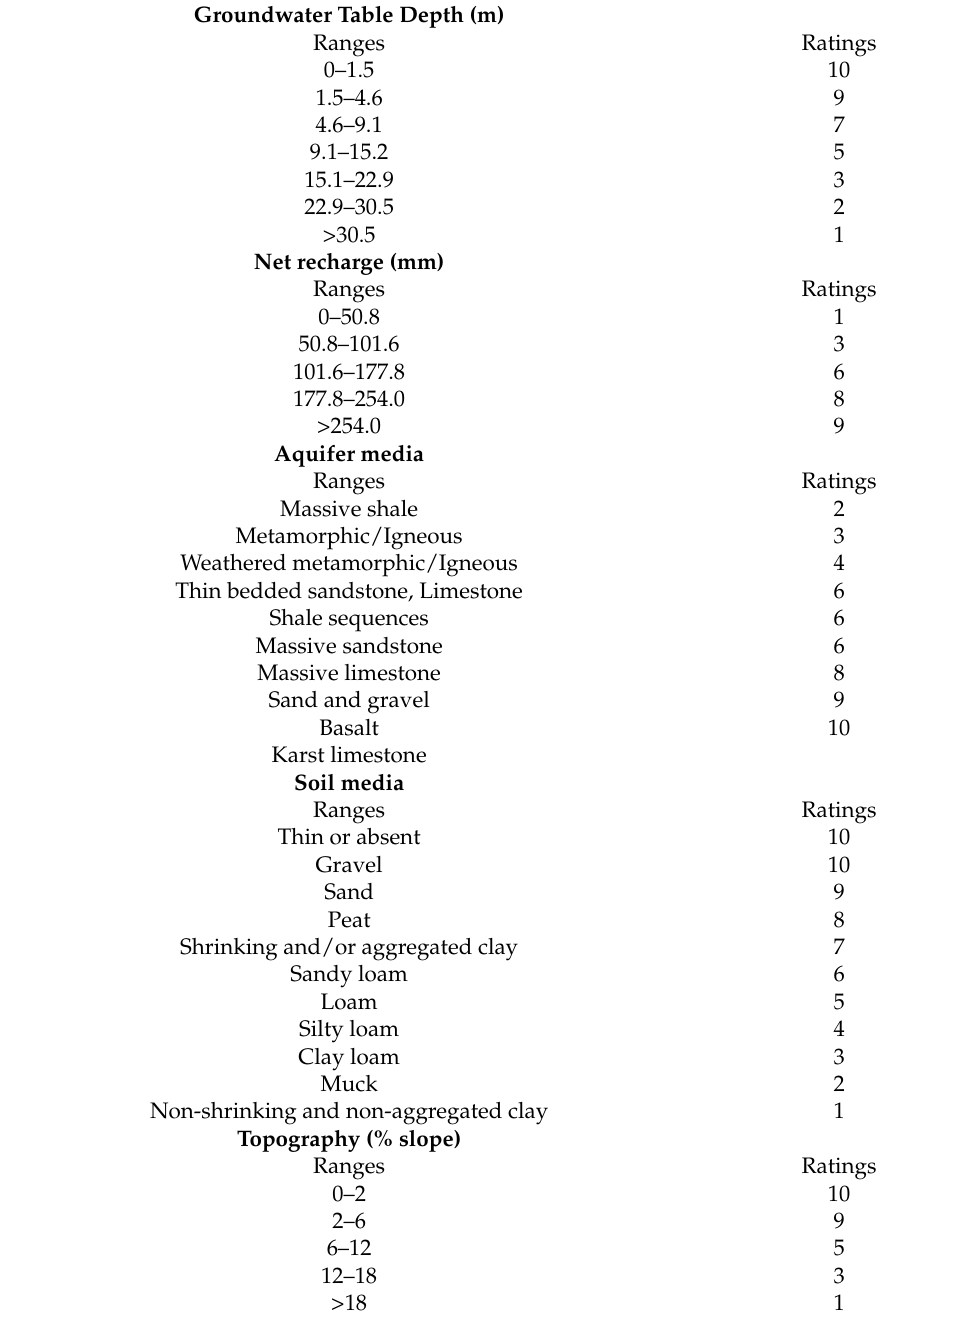
Table A1. Ranges and rates for O-DRASTIC